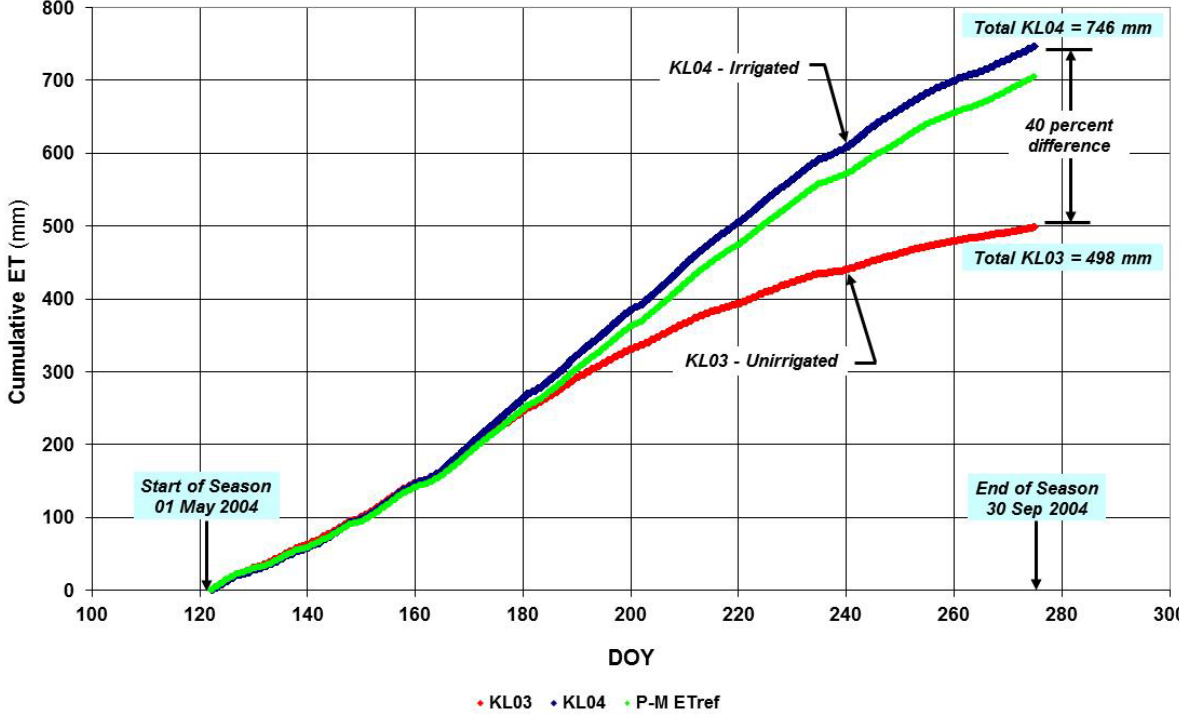
Figure 6. Bowen ratio station comparison for cumulative evapotranspiration for KL03 (unirrigated) and KL04 (irrigated), with Penman-Monteith reference evapotranspiration (ET) for grass ( ET ) for comparison, from start to the end of irrigation season, DOY 122 ref (1 May) to 274 (30 September),